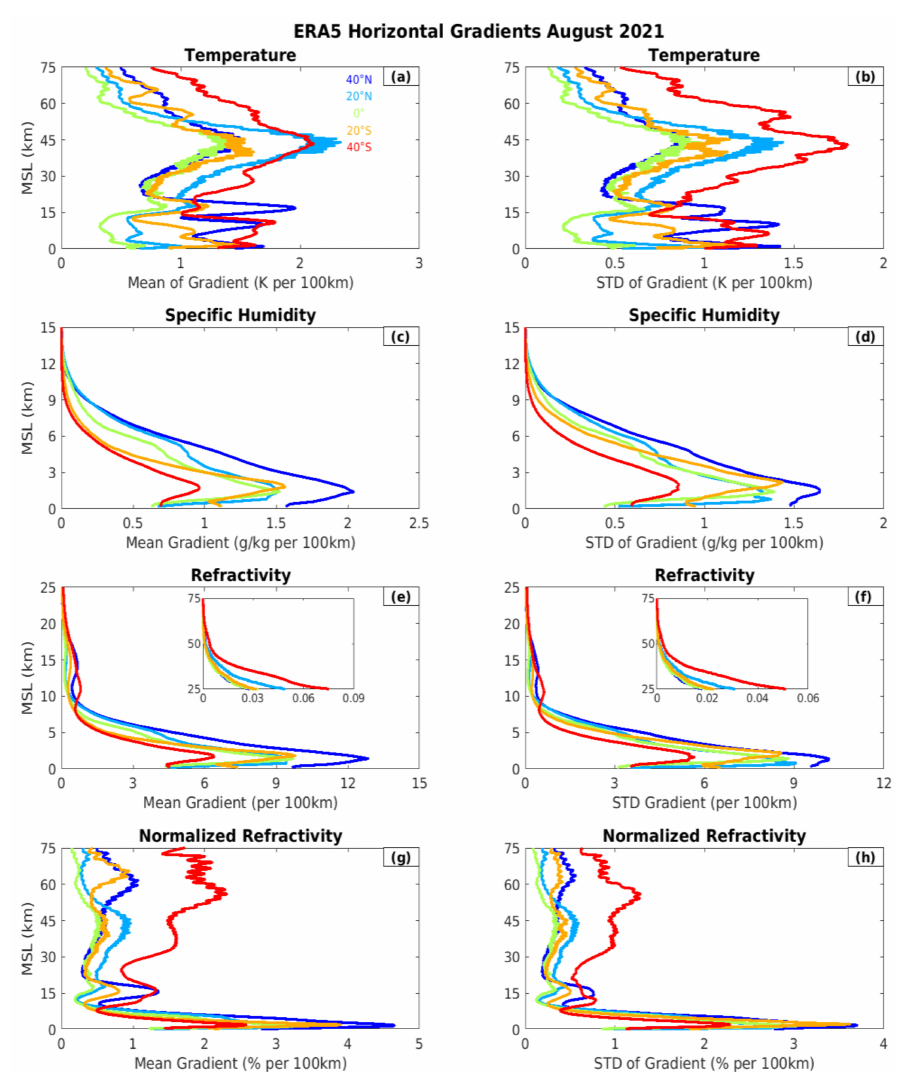
Figure 3. Vertical profiles of the mean and standard deviations of the horizontal gradients of T in K/100 km (top row, ( a , b )); q in g/kg/100 km (second row, ( c , d )); refractivity in N-units/100 km (third row, ( e , f )); and normalized N in %/100 km (bottom row, ( g , h )). Gradients are computed from ERA5 reanalysis on constant MSL height surfaces for August 2021 and are presented for five latitude bands with 10 ◦